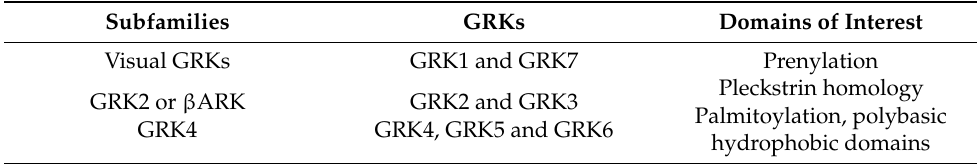
Table 1. GRKs that putatively phosphorylate different sites in